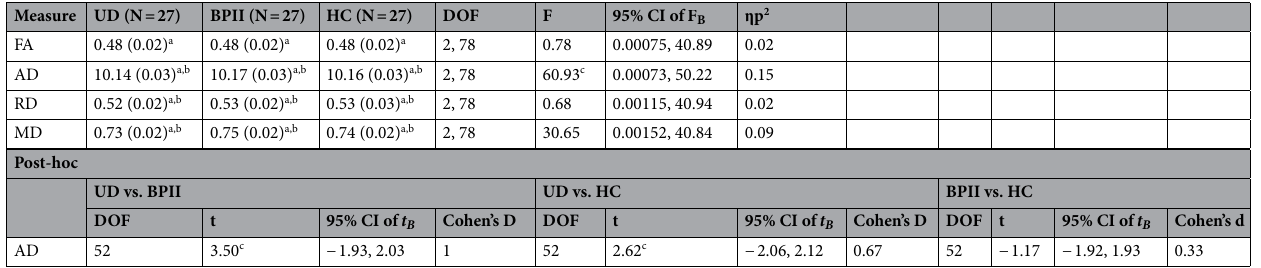
Table 1. DTI measures at right superior longitudinal fasciculus and ANOVA results. CI confidence interval, F B bootstrapped F statistics, DOF degrees of freedom, t B bootstrapped t statistic, UD Unipolar Depression, BPII Bipolar II Disorder, HC healthy control, FA fractional anisotropy, AD axial diffusivity, RD radial diffusivity, MD mean diffusivity. a Mean (SD). b Multiply by 10 –3 . c Statistically significant, where the observed statistics was not within the 95% CIs of the bootstrapped